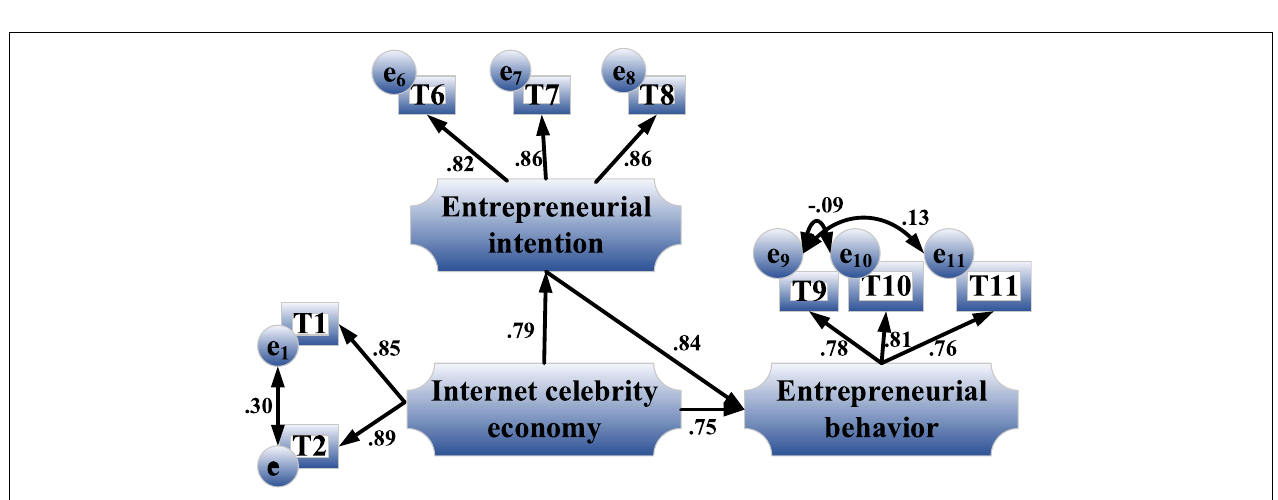
FIGURE 11 | Path coefficient diagram of the direct impact of entrepreneurial values on entrepreneurial behavior.